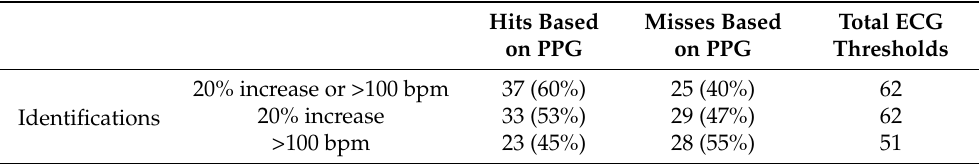
Table 1. Number of hits and misses and corresponding number of determinable ECG thresholds.